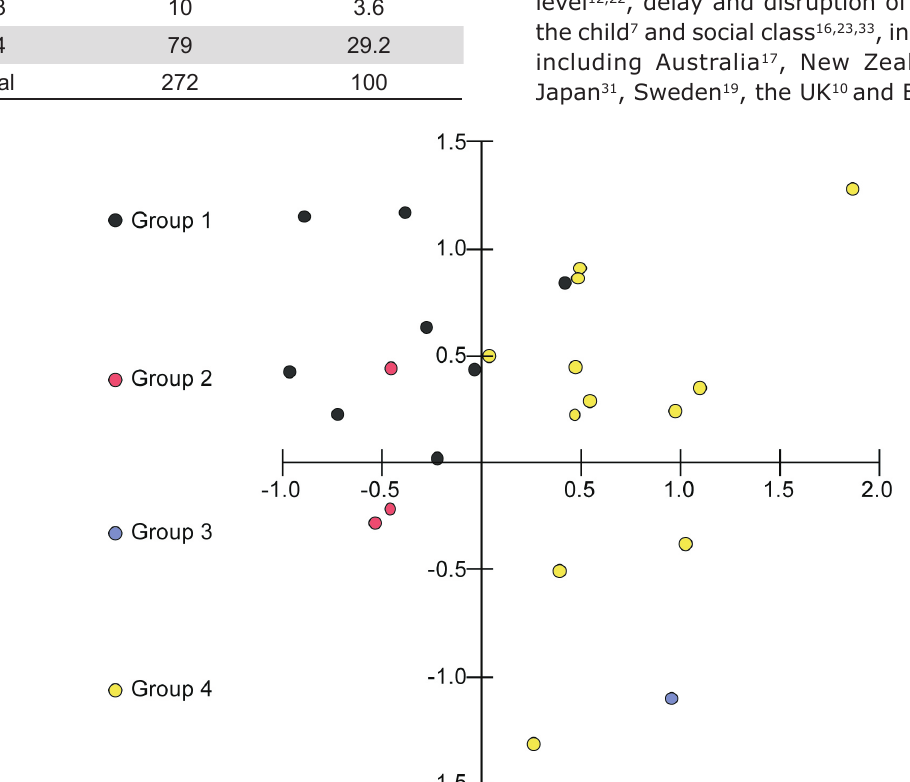
Figure 1- Spatial discrimination analysis of groups G1, G2, G3, and G4 according to the maternal need for dental treatment and the caries history of the child. Population sample is children attending public institutions of early childhood education in southern Brazil and their